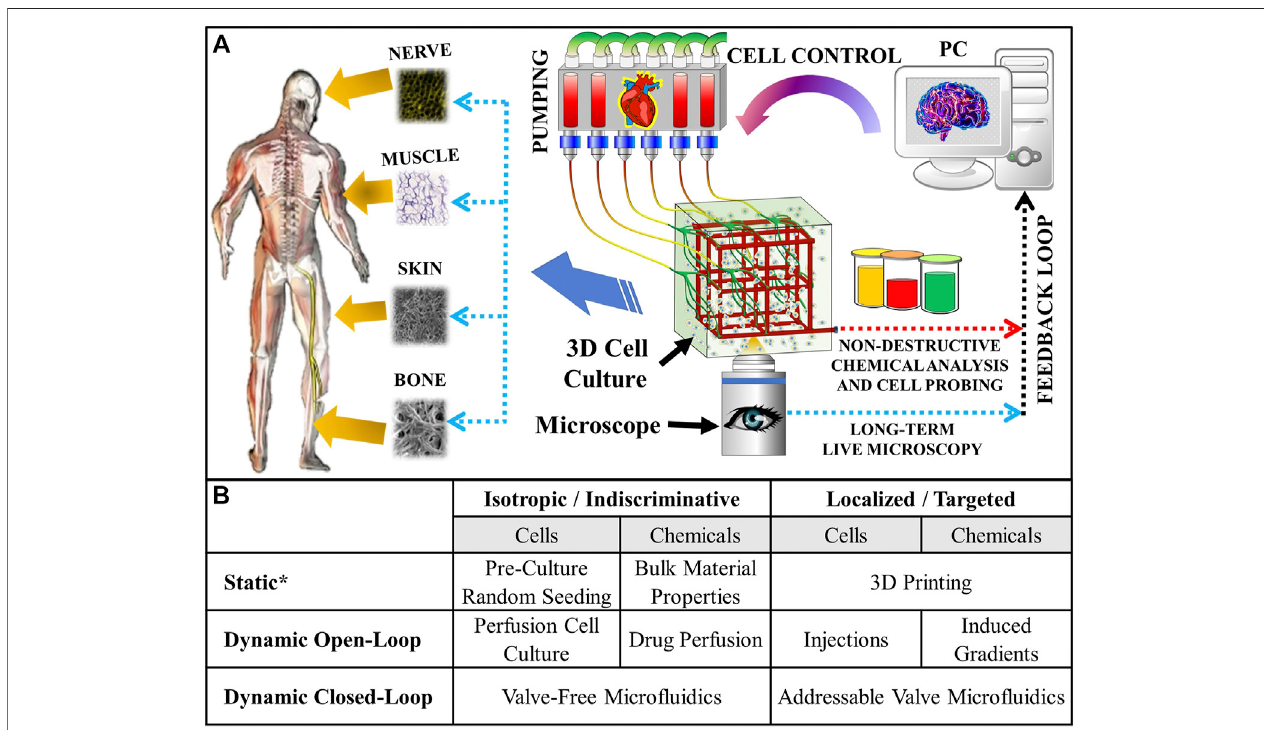
FIGURE 1 | (A) Concept of the micro fl uidic scaffold with active “ vasculature ” that enables targeted real-time fl uid and cell manipulation within the cultured tissue. External pumping acts like a “ heart ” , while the whole process is orchestrated by a computer acting like a “ brain ” . The computer ’ s closed-loop responses are based on feedback from non-destructive chemical analysis and long-term live microscopy throughout the entire duration of the culture. Viable arti fi cial tissue is cultured automatically and reproducibly. (B) Types of cell and/or fl uid manipulations possible in tissue engineering scaffolds. * “ Static ” refers to one-time manipulations — usually performed at the start of the experiment. The addressable valve micro fl uidics hold numerous advantages over the conventional culturing methods, including the potential for enabling minimally disruptive localized additive (e.g., cell and drug delivery) and subtractive (e.g., probing cell secretions, collecting biopsies, making corrections by removing tissue overgrowth, etc.) manipulations, which can be used to implement closed (i.e., in response to real time feedback) loop controls. These are essential for growing complex spatial tissue patterns that evolve over time: for example, some bones in our bodies start out as cartilage and only subsequently calcify through endochondral ossi fi cation(Scotti et al., 2010; Farrell et al., 2011).